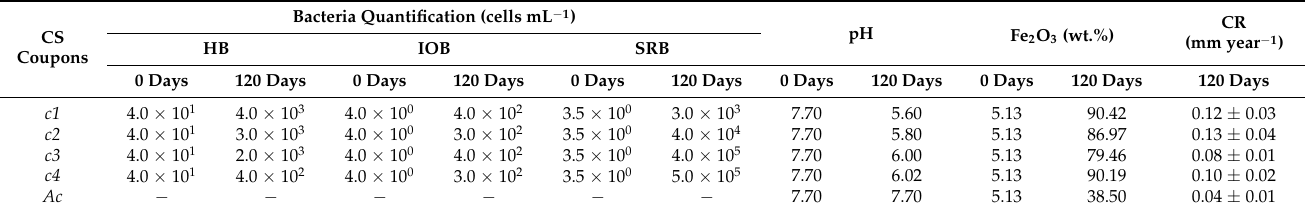
Table 2. Biocorrosion of carbon steel coupons exposed to the water